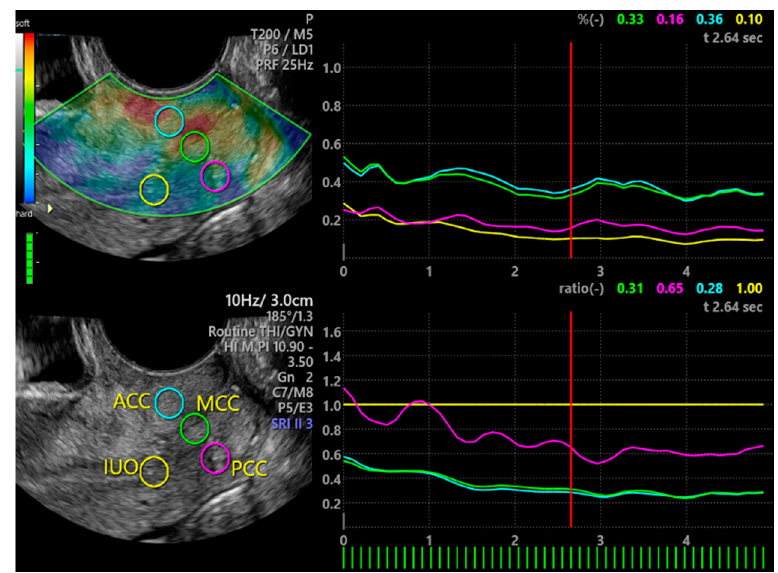
Figure 1. Elastography of uterine cervix. On the left, the two vertical bars indicate the colorimetric scale (upper bar) and the control bar (lower bar) that when full green indicates optimal compression force. Circles indicate ROIs. On the right are the numerical index and graphical representation of ROI’s percent tissue deformation (upper panel) and numerical index and graphical representation of ratio between IUO percent tissue elasticity (as reference) and other ROIs. ACC = anterior cervical compartment; PCC = posterior cervical compartment; IUO = internal uterine orifice; MCC = middle cervical canal.